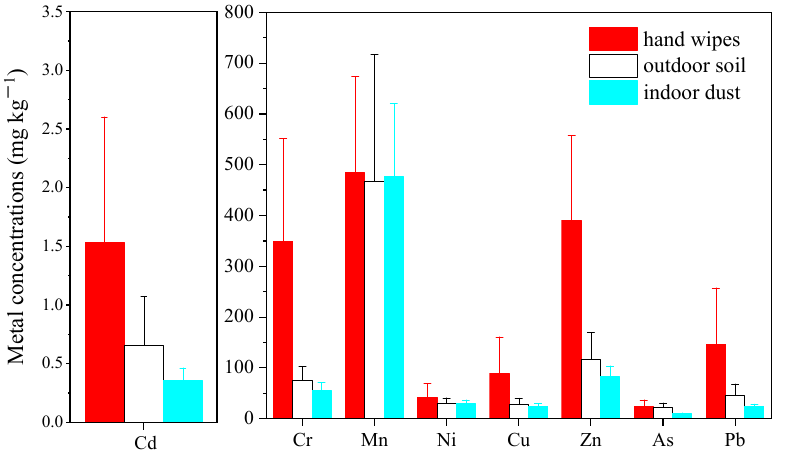
Figure 1. Comparison of metal concentrations via hand wipe, outdoor soil and indoor dust.